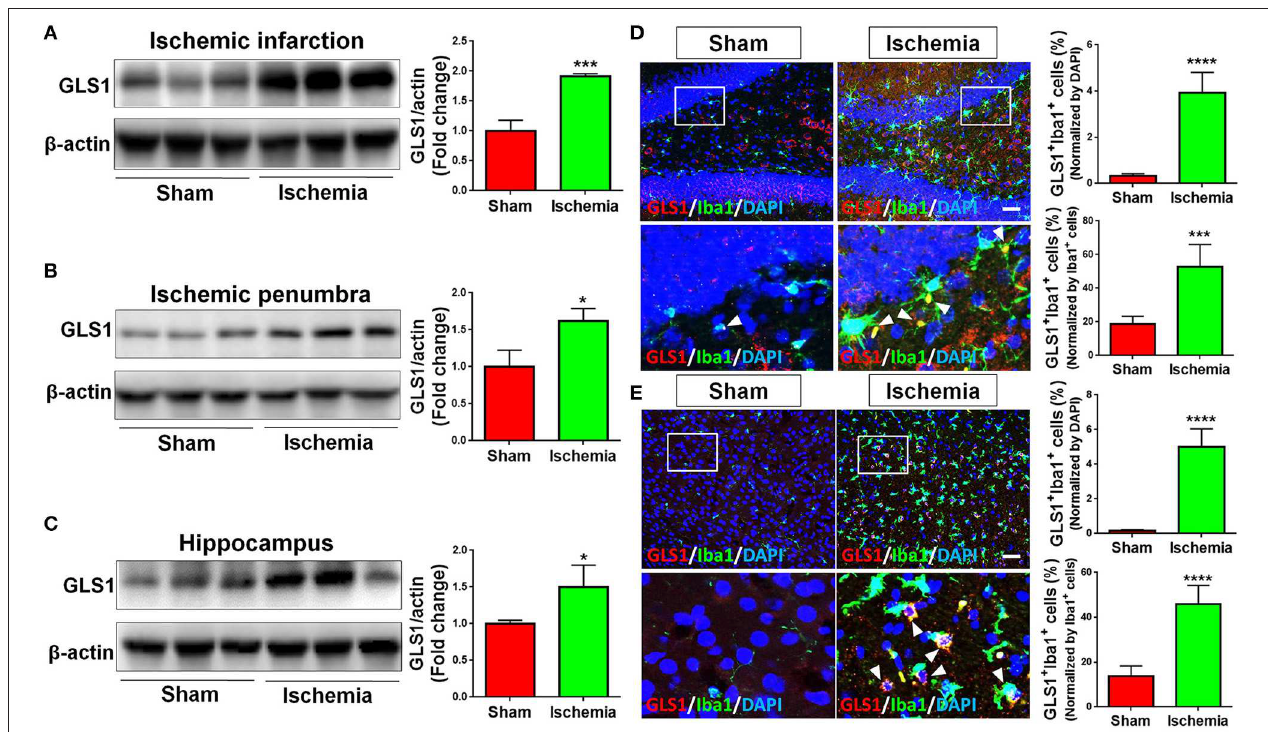
FIGURE 2 | Up-regulation of GLS1 in focal cerebral ischemic brain. (A–C) Representative blot and quantification of GLS1 protein expression levels in ischemic infarction (A) , ischemic penumbra (B) , and hippocampus (C) . (D,E) Focal cerebral ischemic brains and their sham controls were removed after intracranial perfusion and prepared for immunofluorescence staining. Representative pictures of GLS1 and Iba1 immunoreactivities in the hippocampus (D) and cortex (E) of focal cerebral ischemic rat brain sections and control rat brain sections were shown. Images at the lower panels were high-magnification images of the corresponding small box area from the upper panels. Quantification of Iba1 + /GLS1 + cells among total cells or Iba1 + cells co-expressing GLS1 immunoreactivities was provided on the right panel. Scale bar: 100 µ m. Data were normalized to β -actin and presented as fold change compared with those in sham rat brain. Error bars denote s.d. from triplicate measurements. * p < 0.05, *** p < 0.001, and **** p < 0.0001 by two-tailed t -test ( n =